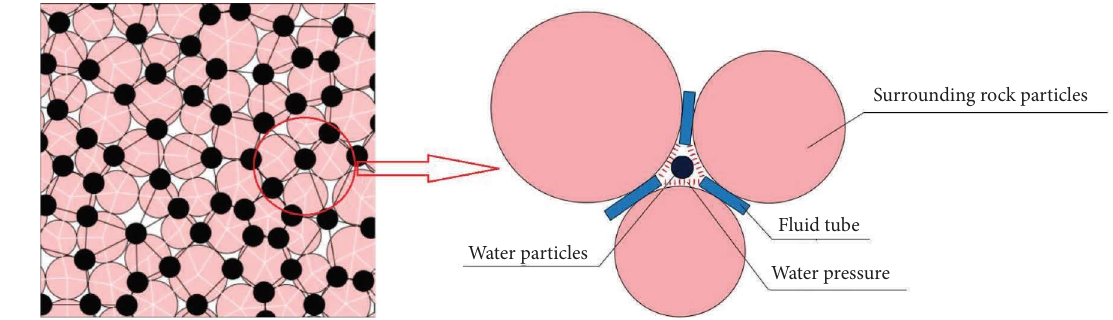
Figure 13: Flow tube network model. Table 3: Microparameters of the fuid grid.